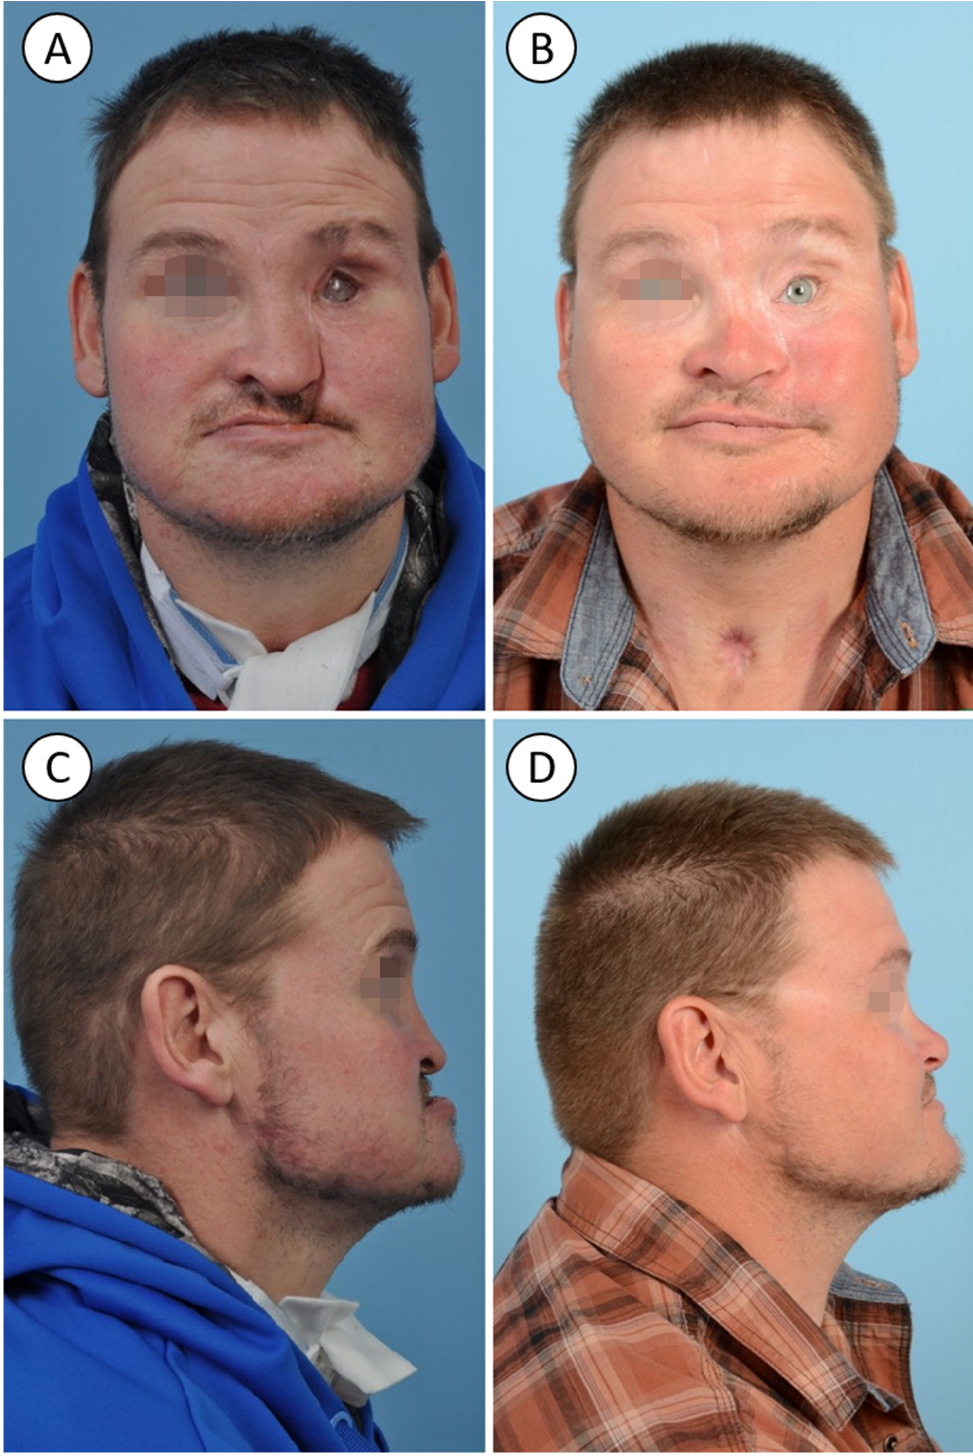
Figure 3. 35-year old male who suffered a self-inflicted gunshot wound to the face resulting in severe comminuted fractures of midface, zygoma, mandible, and loss of left globe, orbital floor, and inferior orbital rim. Photos ( A , C ) prior to and ( B , D ) after midface and nasal reconstruction with free fibula flap and dorsal nasal cartilage onlay graft. Table 3. Psychiatric and substance use histories of patient cohort (N = 22).